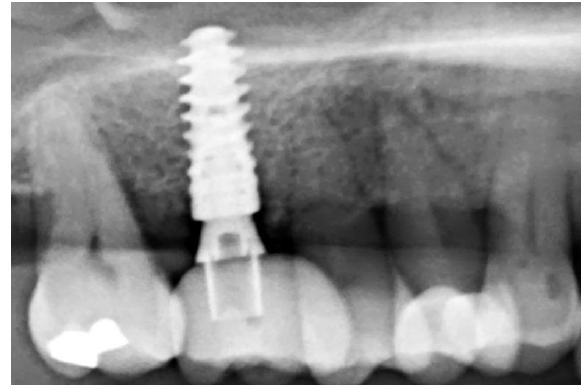
Figure 14. Radiological follow-up after 26